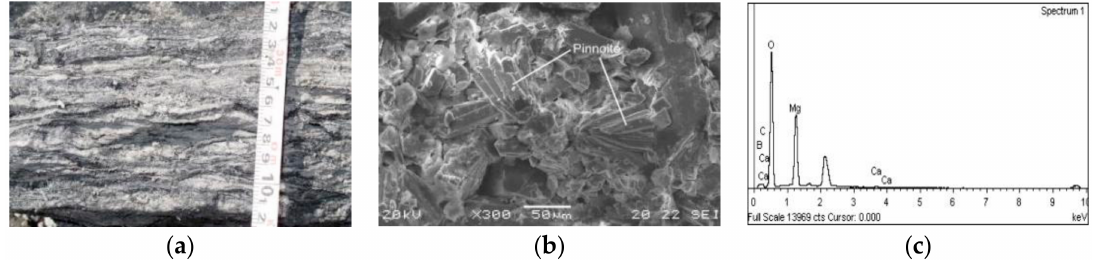
Figure 4. ( a ) Cemented pinnoite orebody with the sedimentary structure of light-dark lamination couplets; ( b ) Scanning electronic microscopy (SEM) microphotograph of pinnoite crystals in the orebody; ( c ) An energy dispersive X-ray (EDX) spectrometer spectrum of all elements of the pinnoite crystal on the right ( b